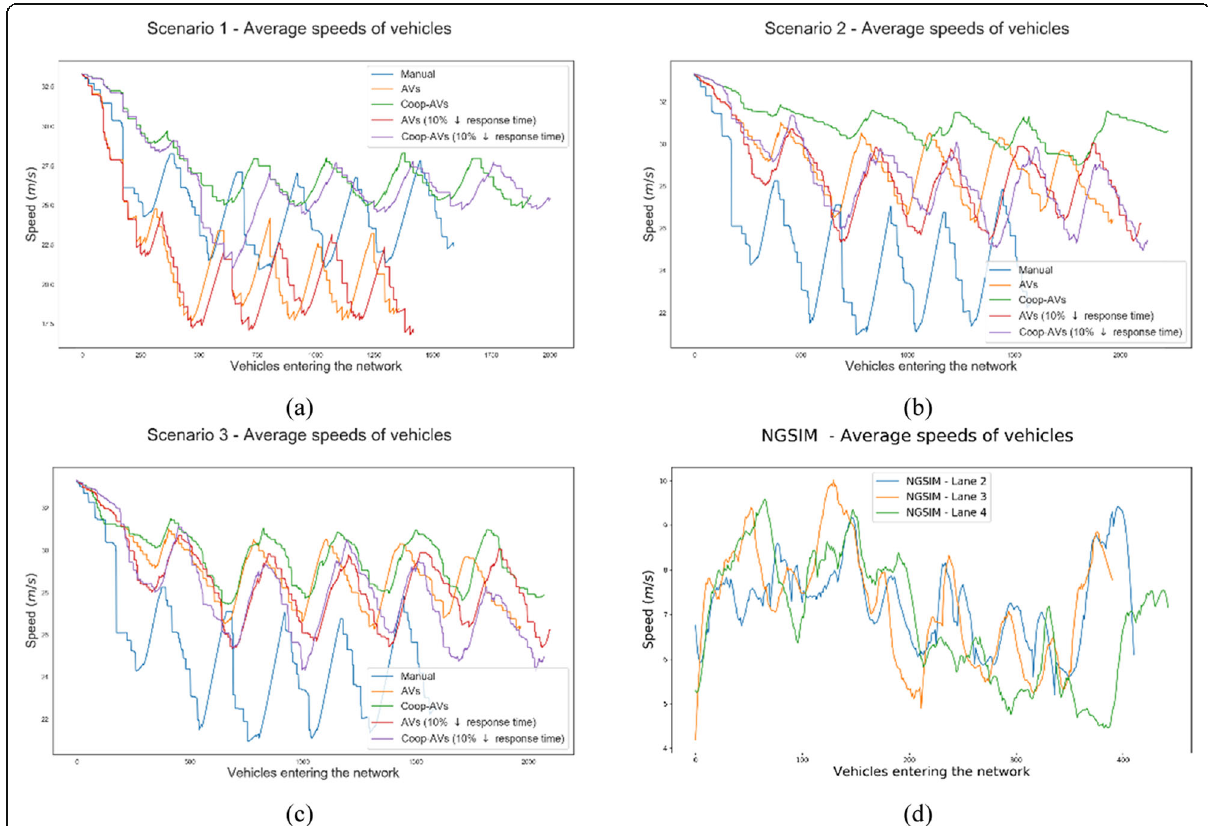
Fig. 7 Average speed per vehicle, for all the vehicles entering the network. Sample simulation tests for Scenarios 1, 2 and 3 are shown in figures a ), b ) and c ). Figure d ) shows empirical observations in three lanes in a congested segment of the NGSIM